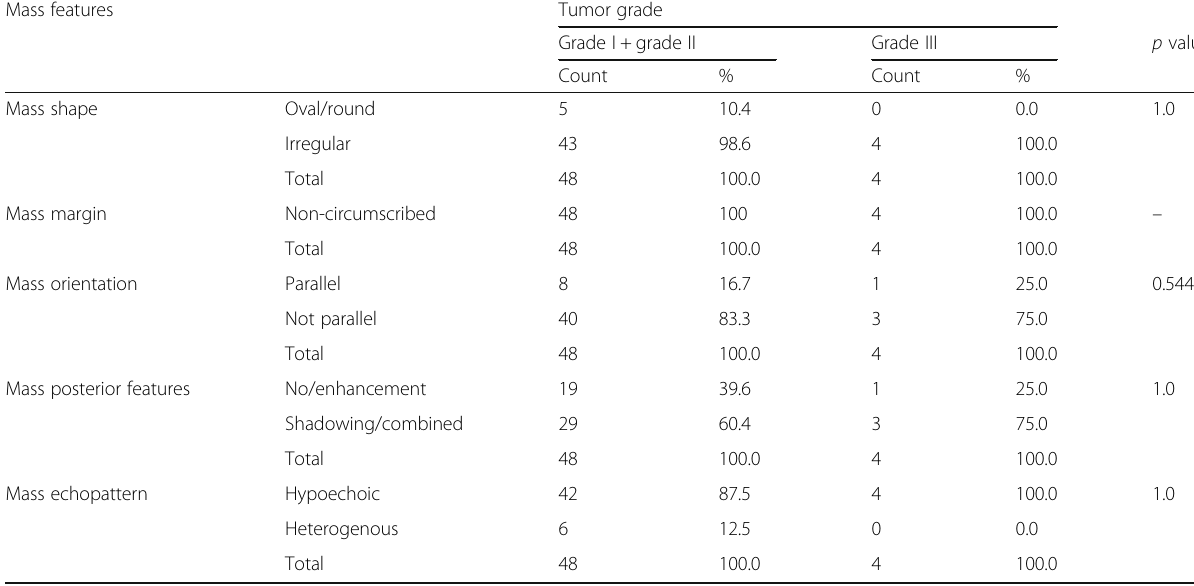
Table 3 Association between tumor grade and ultrasound findings of invasive breast cancers